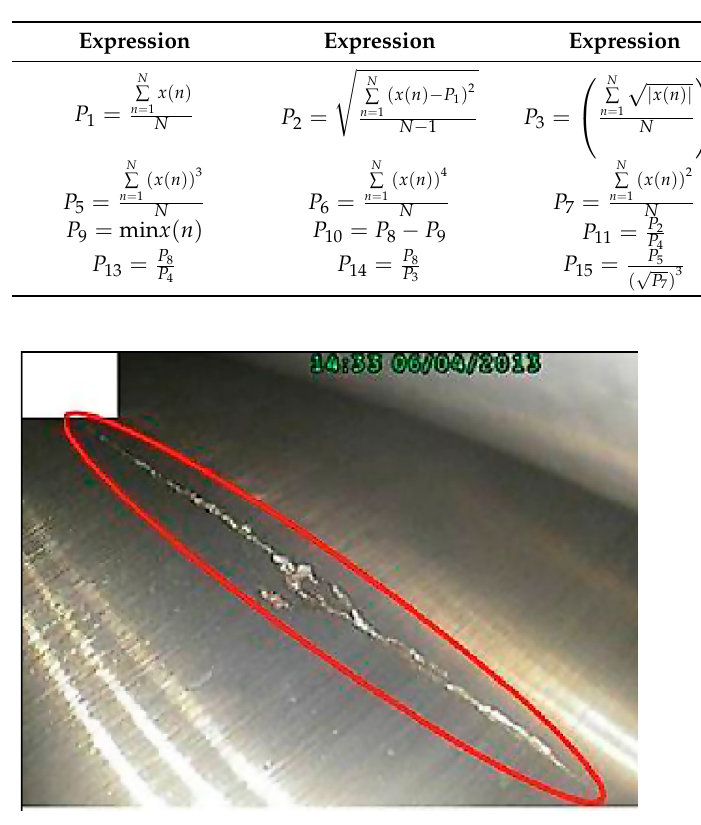
Table 1. Time-domain features.